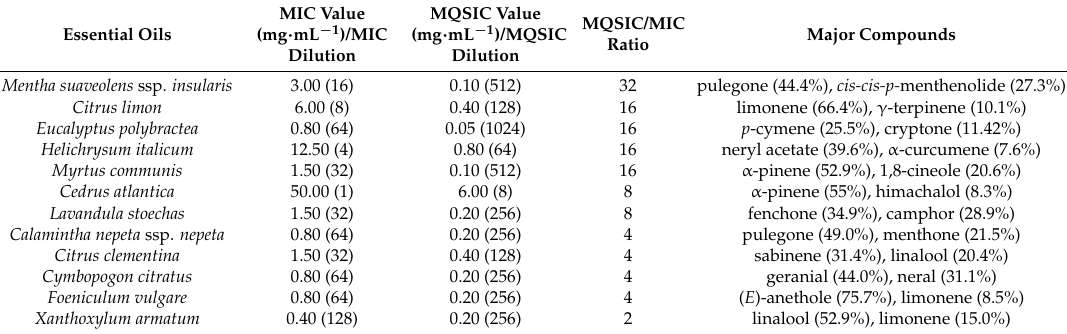
Table 1. Determination of anti-QS activities of tested essential